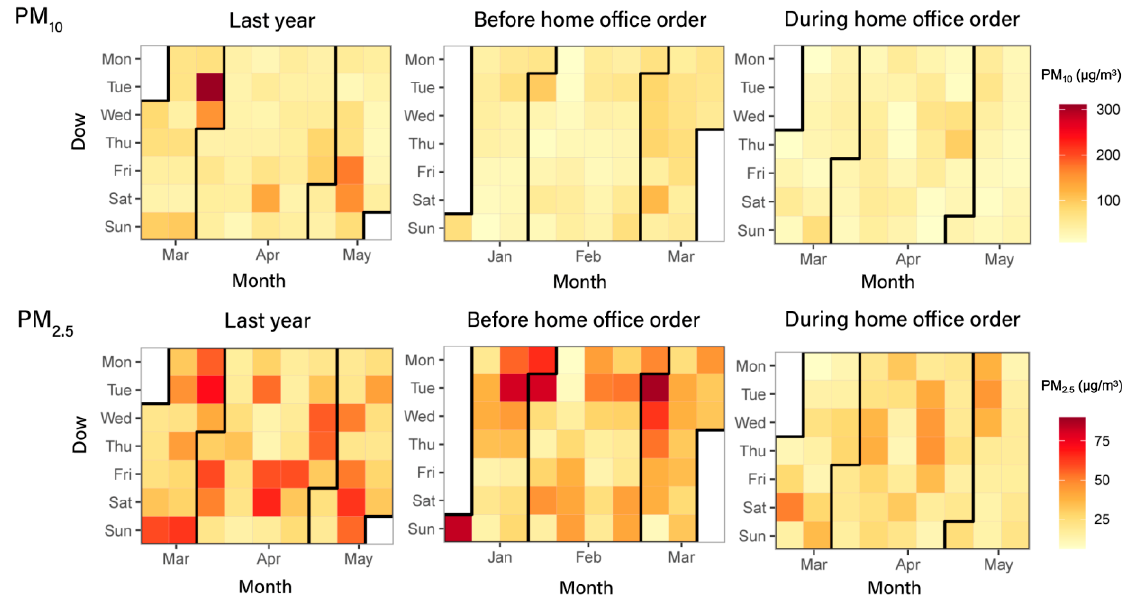
Figure 3. The calendar heatmaps of daily PM 10 and daily PM 2.5 concentrations before and during implementing the home office order in Shanghai. implementing the home office order in Shanghai.